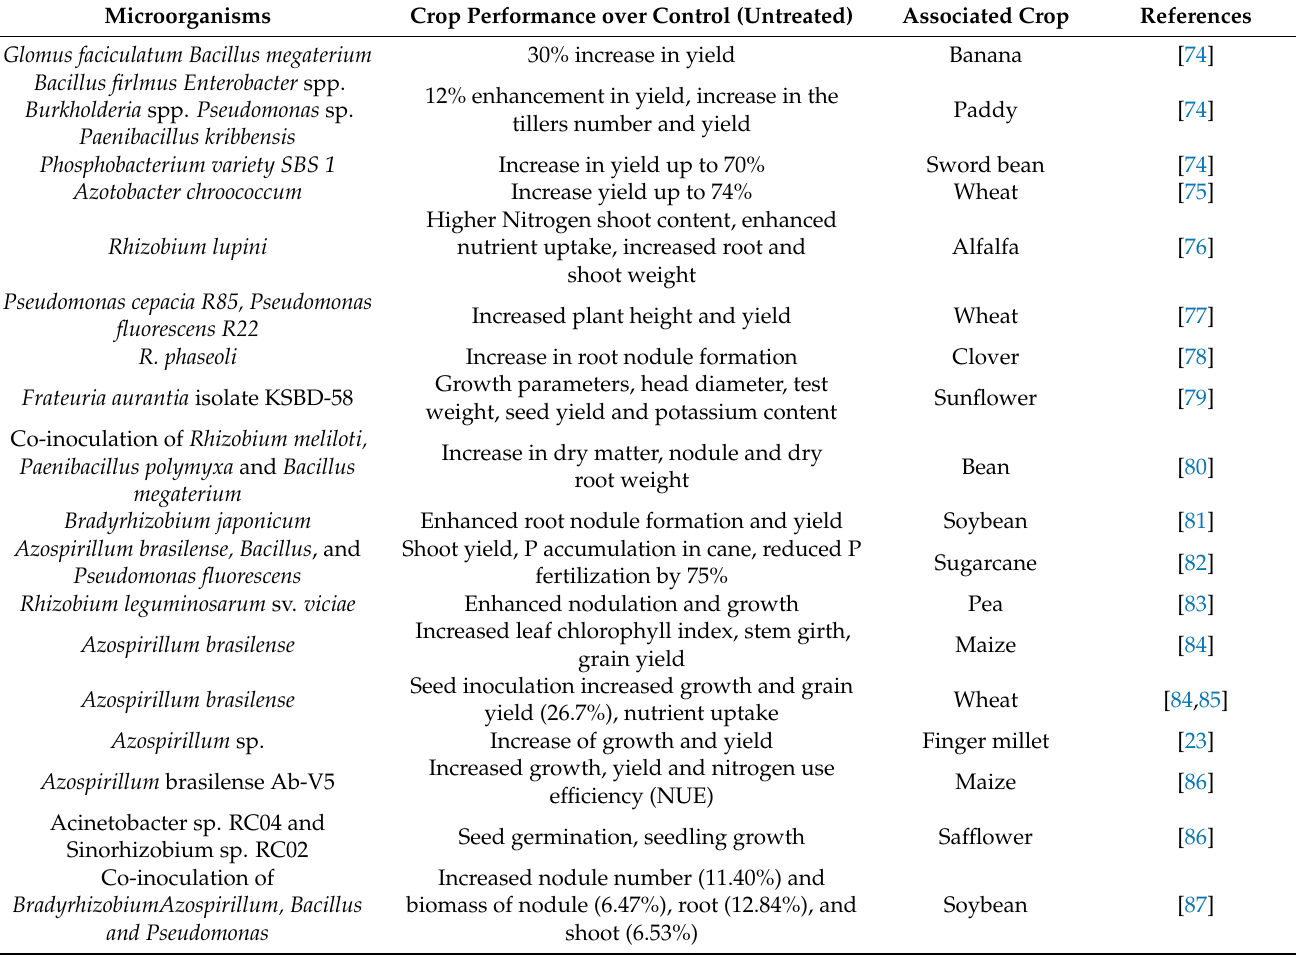
Table 1. Inoculation of microorganisms facilitated crop growth by the availability of nutrients. Microorganisms Crop Performance over Control